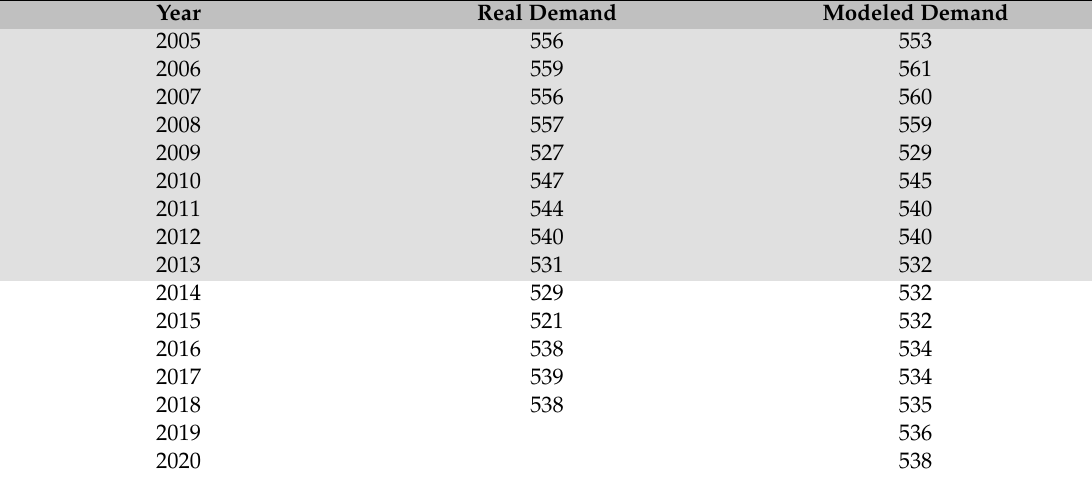
Table 4. Consumption by year in Germany, market data vs model in TWh (source: etsoe.eu). Year Real